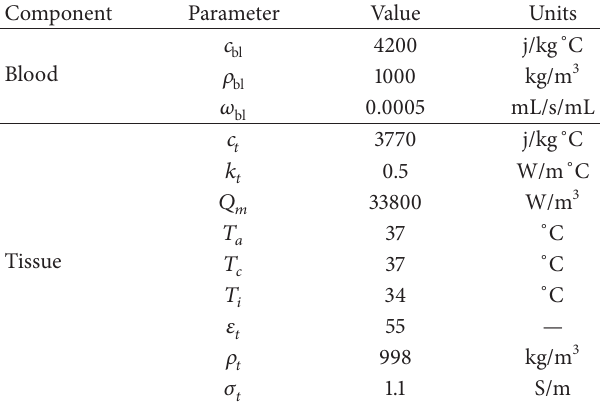
Table 1: Biophysical characteristics of